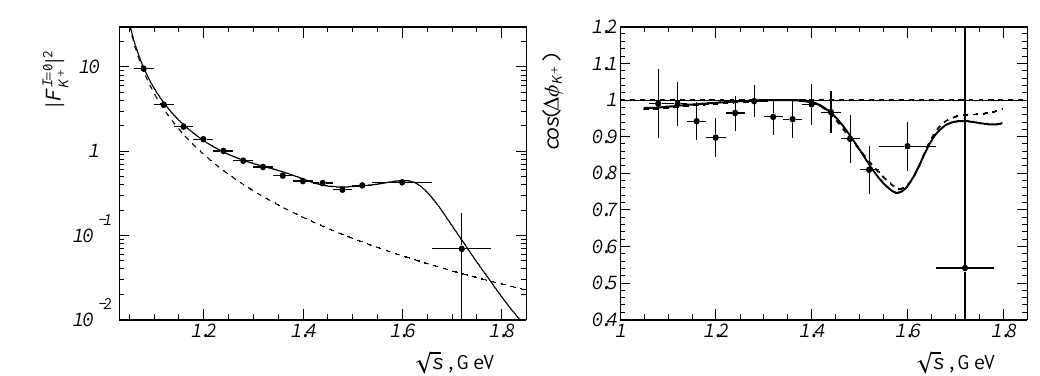
Figure 2. Left panel: The isoscalar kaon form factor squared calculated using Eqs. (11) from e + e − and τ data as a function of √ s . The solid curve represents the results of the fit (Model II) described in the text. The dashed curve shows the ω (782) and φ (1020) contribution. Right panel: The cosine of the relative phase between the isoscalar and isovector form factors calculated using Eqs. (11) from e + e − and τ data. The dashed and solid curves represent the results of the fit with Model I and Model II described in the text,